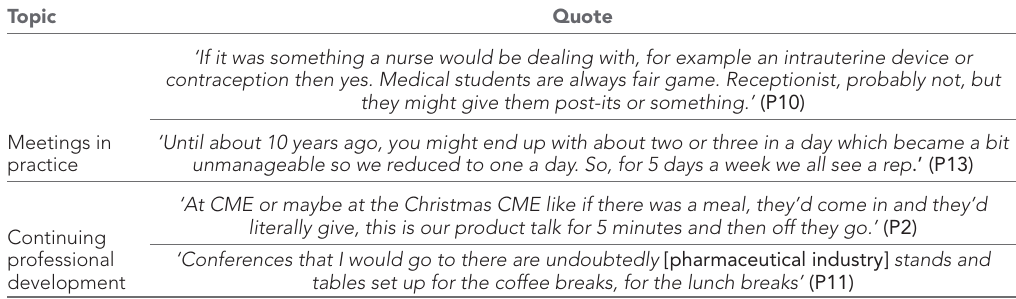
Table 2 Illustrative quotes of the interface between GPs and the pharmaceutical industry Topic Quote